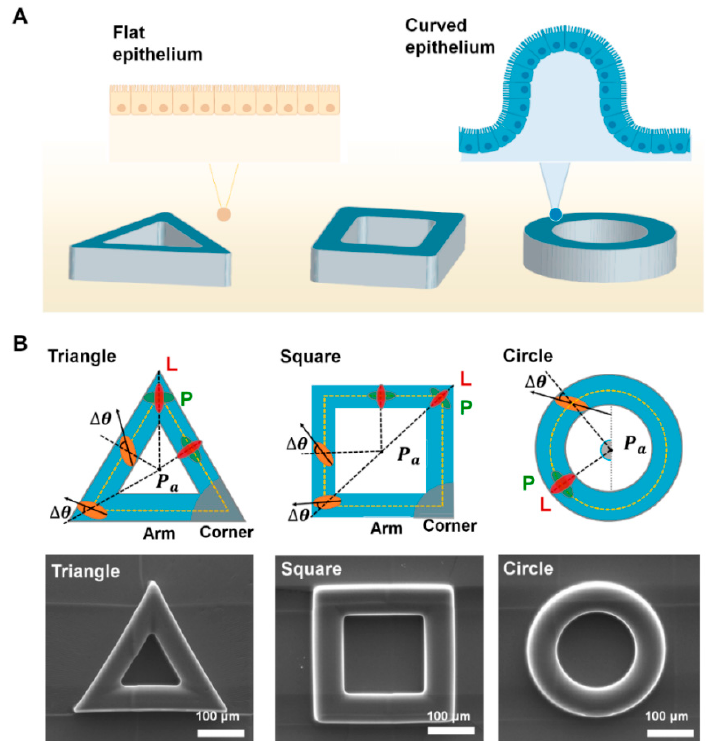
Figure 1. The shape of epithelial tissue and fabricated convex geometric structure. ( A ) A schematic of flat and curved epithelium on the designed protruded geometry; triangle, square and circle shape, respectively. The height and diameter of triangle, square, and circle ring structure is fixed as 60 µm. For the cell culture, fibronectin was fully covered on both protruded structure and flat surface. ( B ) The schematics showing cell orientation ( ∆ θ ) on the structure. ∆ θ were measured from main axis of cells from the center of each structure ( P a ); triangle, square, circle geometry. When the cells are oriented from reference axis from P a in longitudinal (L) or perpendicular (P) direction, ∆ θ equals 0 ◦ or 90 ◦ , respectively. The scanning electron microscope (SEM) images of the fabricated structure are shown in the bottom panel.